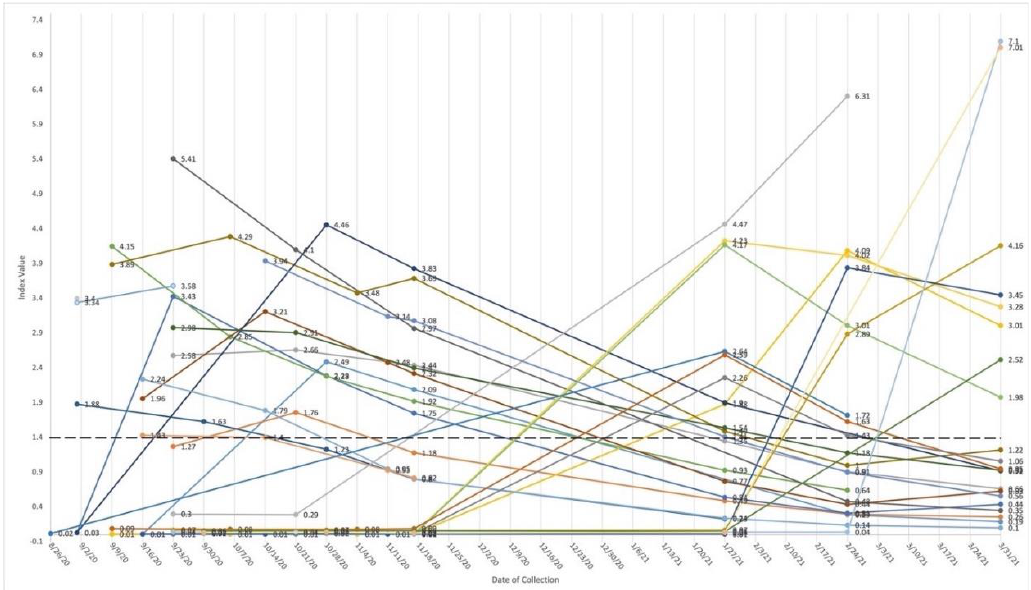
Figure 2. Change in quantity of antiN-IgG for 28 young adults with at least one N-IgG positive result, 26 August 2020–31 March 2021. Each individual is represented by a colored line from first testing date to last testing date. Number at dot is index value. An index value greater than or equal to (≥) 1.4 is positive (bold dotted line). The chemiluminescent microparticle immunoassay (CMIA) captures antibodies reactive with the Nucleocapsid (N) protein and specifically detects IgG only. This qualitative assay reports a ratio of luminescence between sample and calibrator (the S/C index) (Abbott Architect i2000 2). One N-IgG positive participant enrolled and withdrew in September (2 data points); one participant had one study visit in September 2020 (1 data point). Three participants tested positive at last study visit date (1 data point). The remaining 23 provided N-IgG measures across multiple weeks.